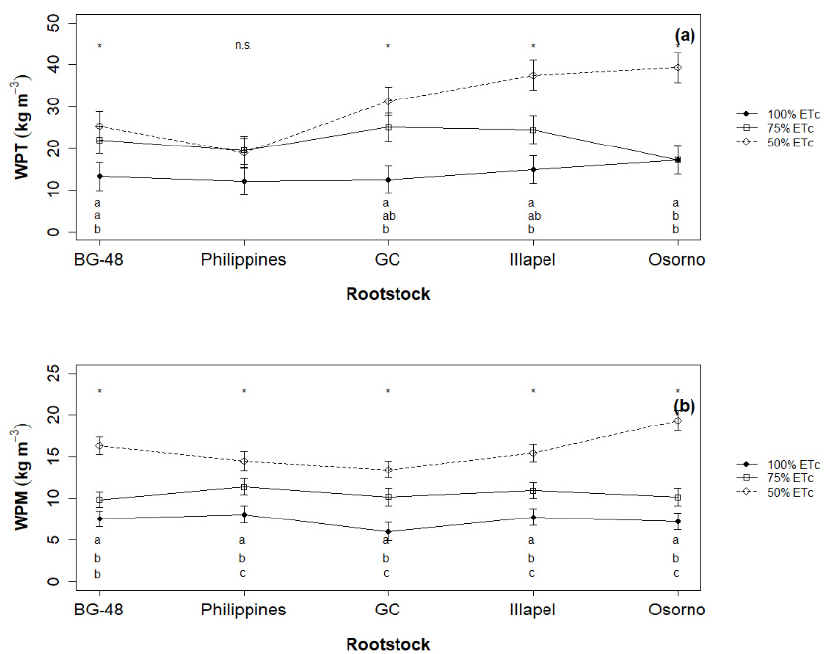
Figure 1. Water productivity based on total yield (WPT, kg m − 3 ) ( a ) and marketable yield (WPM kg m − 3 ) ( b ) at three irrigation levels of watermelon cv. Santa Amelia F1 grafted onto five L. siceraria rootstocks. * and n.s denote the level of significance at 5% and non-significant re-spectively, according to Fisher’s LSD test with Bonferroni